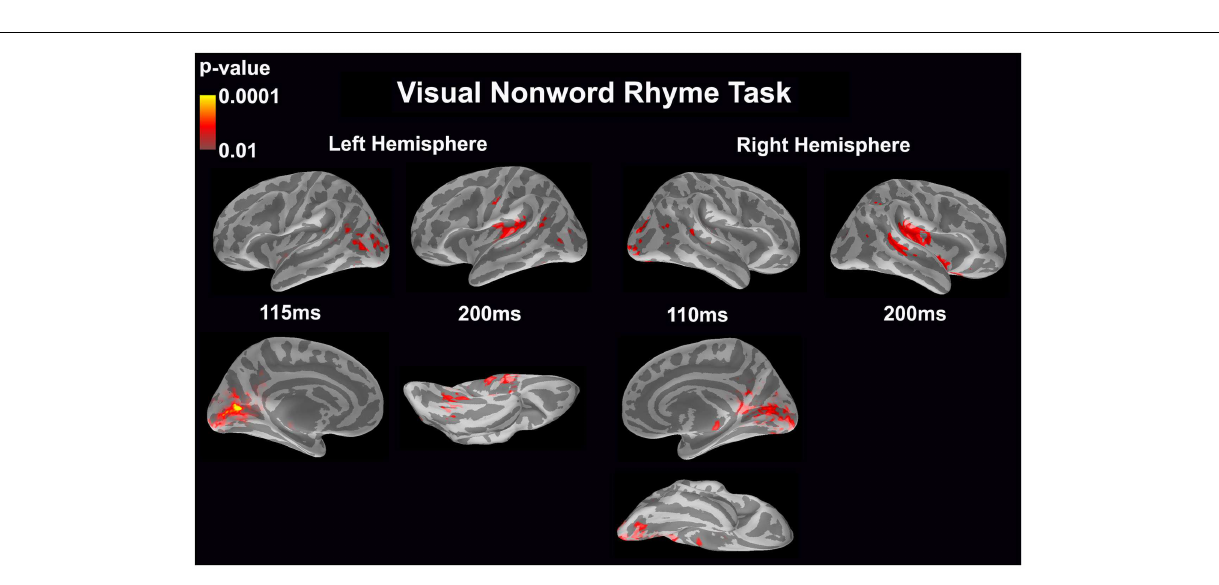
FIGURE 3 | Cortical activation during the visual non-word rhyme task is shown . Dynamic statistical parameter maps represent cortical activation averaged across 15 children with epilepsy with times representing latency from the onset of the visual non-word stimulus, which was centered on the screen in front of the